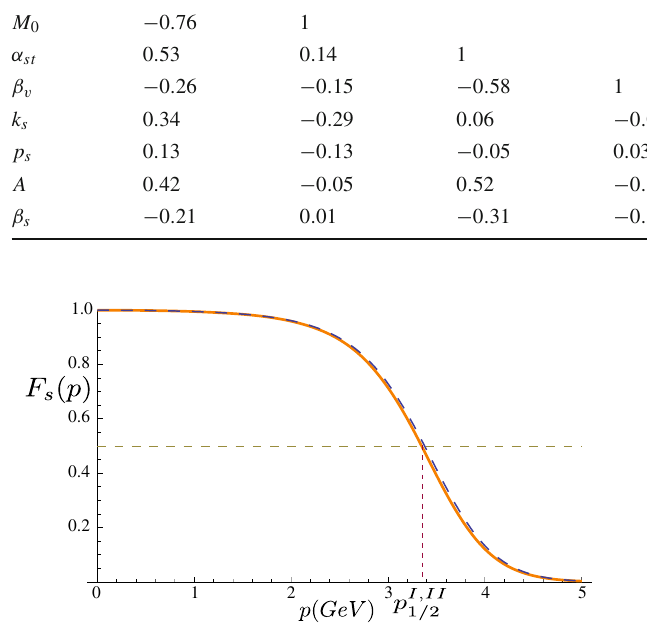
Fig. 3 Screening function for potentials I (dashed blue) and II (solid orange). For k s and p s we use the central values in Table 2. We high- light the values of the screening momenta p I (potential II) introduced in